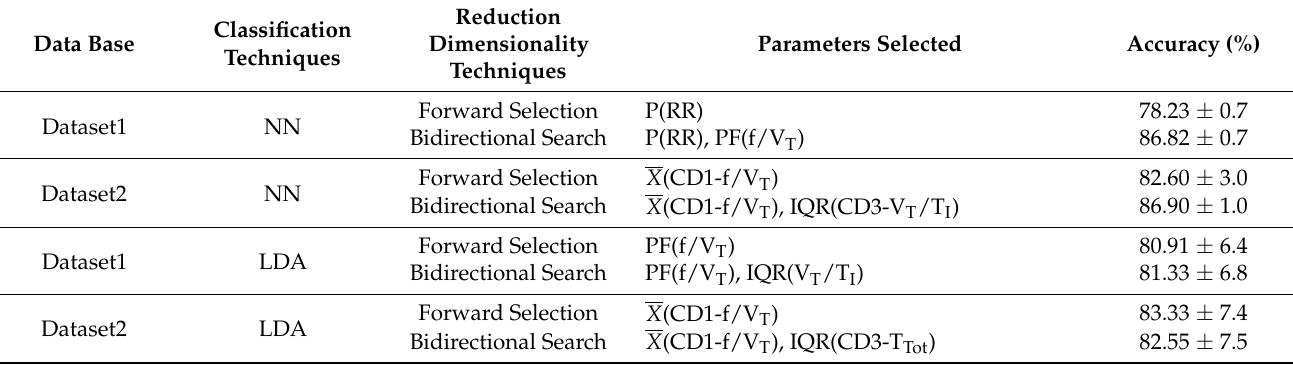
Table 4. Parameters with the highest accuracy (mean ± standard deviation), when comparing the groups of patients SG vs